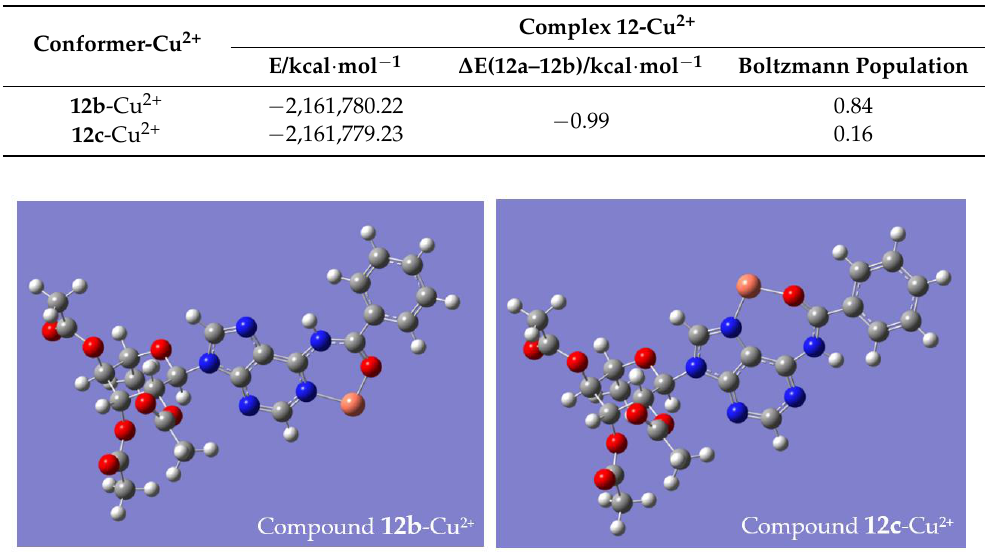
Figure 7. Different views of the molecular electrostatic potential surfaces for complex 12 b- Cu 2+ determined in Gaussian16 with CAM/B3LYP/def2TZVP and IEFPCM for water. Furthermore, having noticed that the glycosyl groups have a small contribution to the molecule electrostatic potential, the interaction with the metal ions of the purine in